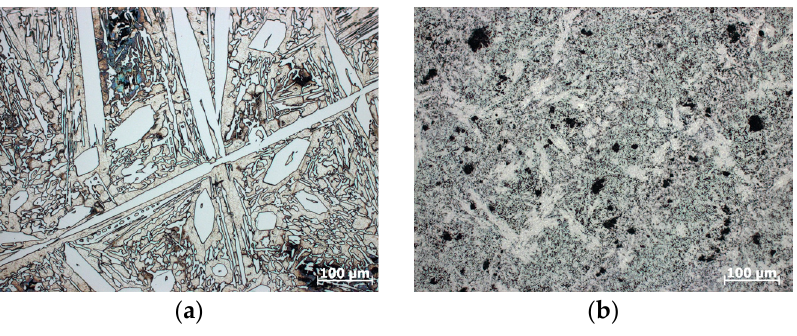
Figure 4. Microstructure of high-chromium cast iron powder: ( a ) TiC-50% high-chromium cast iron binder synthesized powder before sintering at 1300 °C; ( b ) after sintering at 1300 °C.